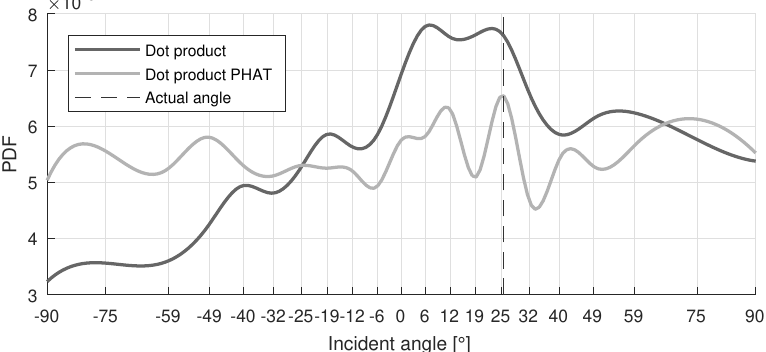
Figure 5. Example of an acoustic PDF with incident angle 26° for WN sound events, where dot product PHAT shows less pronounced